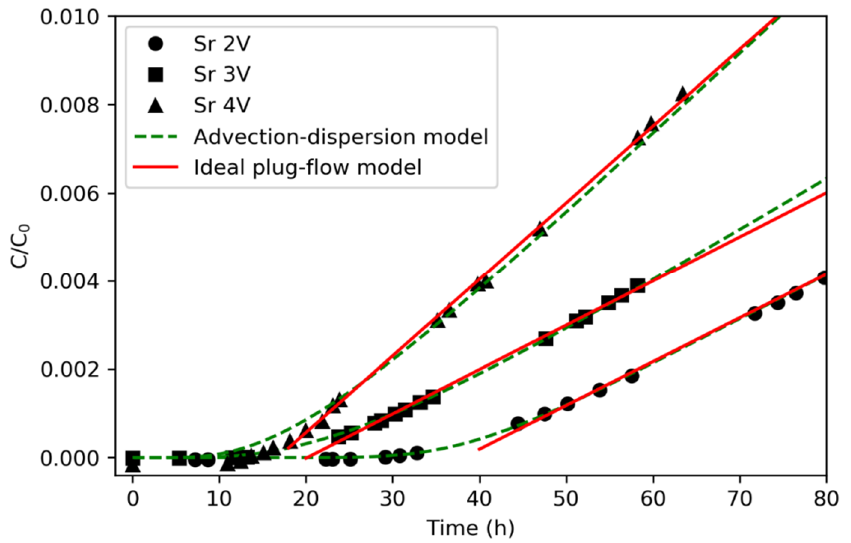
Figure 5. The concentrations of Sr followed in the recipient chamber as a function of time with 0.03 M SrCl 2 in the source chamber. The voltage over the rock sample were 2V, 3V and 4V, respectively.